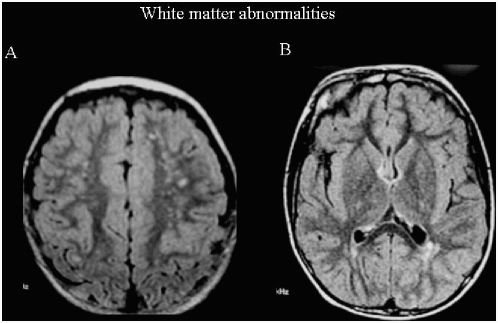
White matter abnormalities in autism.Two children illustrating the principal categories of white matter signal abnormalities. Figure 1A. Punctate T2 Hyperintensity: Abnormal findings were placed in this category when small (<2 mm) rounded abnormalities were found scattered bilaterally in the white matter (white arrow). They were asymmetric and homogeneous, and no findings suggest that necrosis was present. They were very intense compared with adjacent white matter on T2 and FLAIR sequences, and did not involve the basal ganglia, the periventricular white matter fibers or the sub-cortical U fibers. These abnormalities were generally found in association with other supratentorial abnormalities. Figure 1B. Posterior T2 Hyperintensity. Abnormalities placed in this category were “plaque-like areas” of mild white matter hyperintensity relatively symmetrical bilaterally at the posterior horns of the lateral ventricles (black arrow). There was no deformation of the lateral ventricular contour adjacent to these lesions. No abnormality of the sub-cortical U fibers was observed.